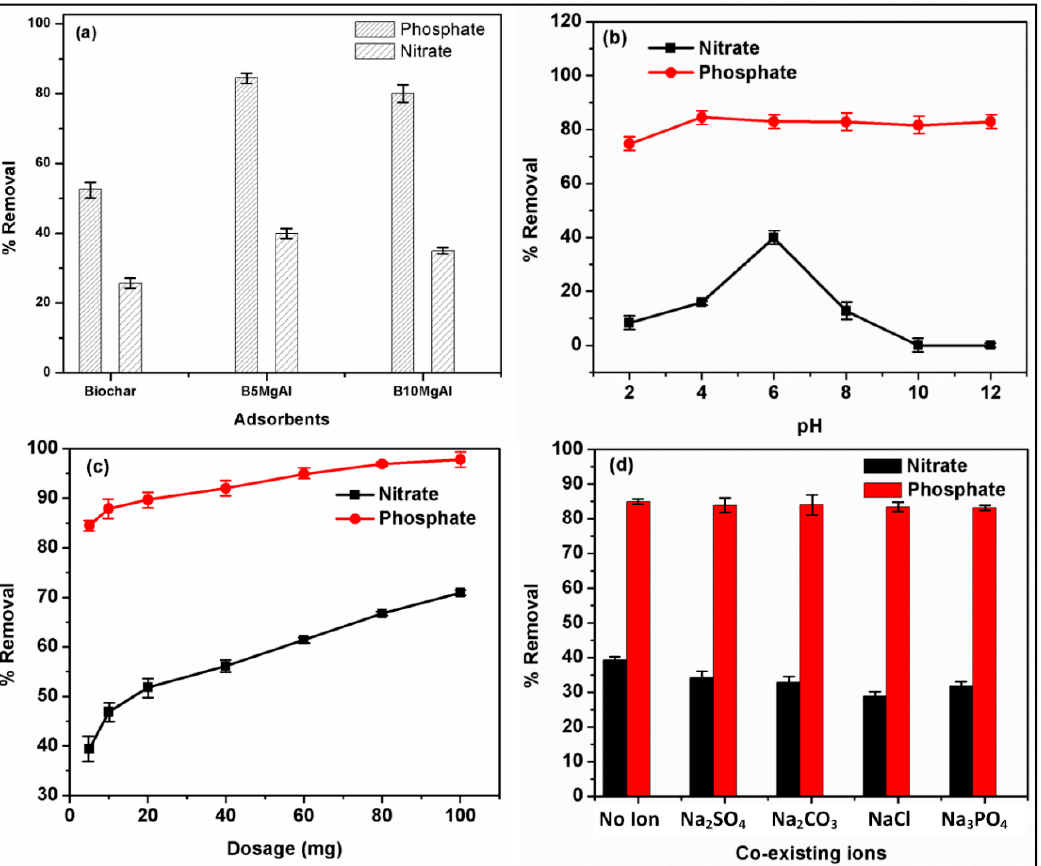
Figure 4. Preliminary experiment of adsorption of phosphate and nitrate by biochar and biochar/MgAl composite ( a ), effect of initial pH ( b ), dosage ( c ), and co-existing ions 0.001 M ( d ) on the percentage removal of nitrate and phosphate onto biochar/MgAl composite.